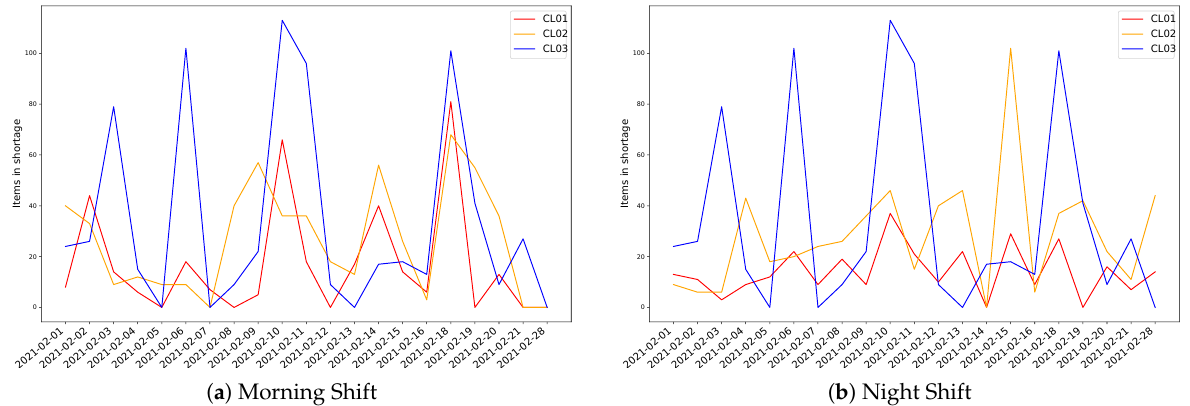
Figure 7. Production Losses at last inspection station per production line and Shift.